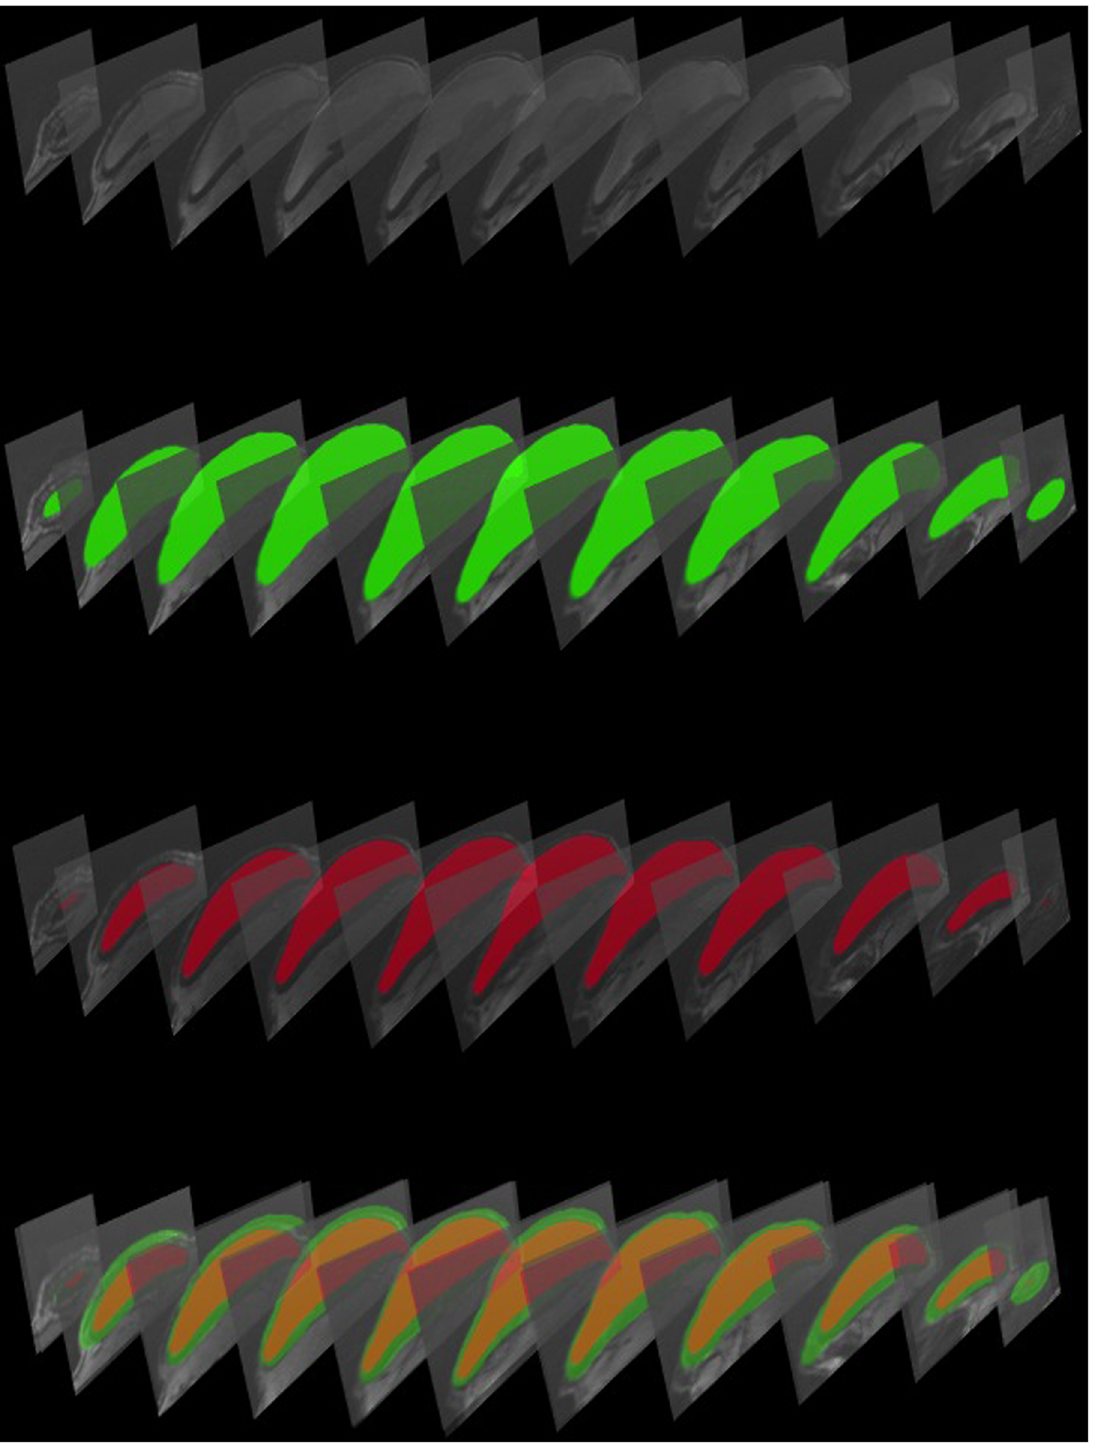
Fig 3. Example pictures of MR images for volumetric measurements. From top to bottom: Blank slides, complete capsule volume (green), implant volume (red) and complete minus implant volume (green margin). Volume calculations were performed via VOLUMEST and the scale was adjusted automatically by the